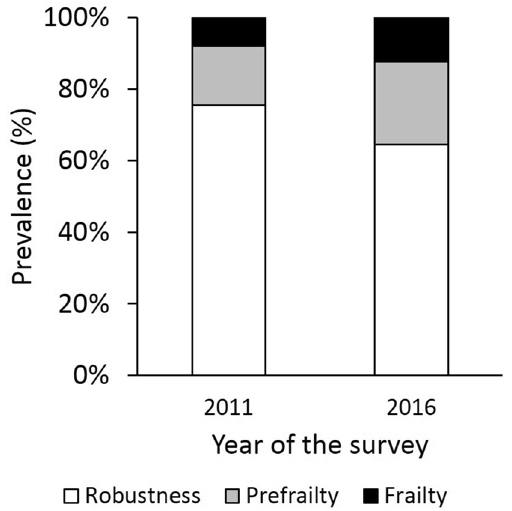
Figure 1. Each frailty status in 2011 and 2016.